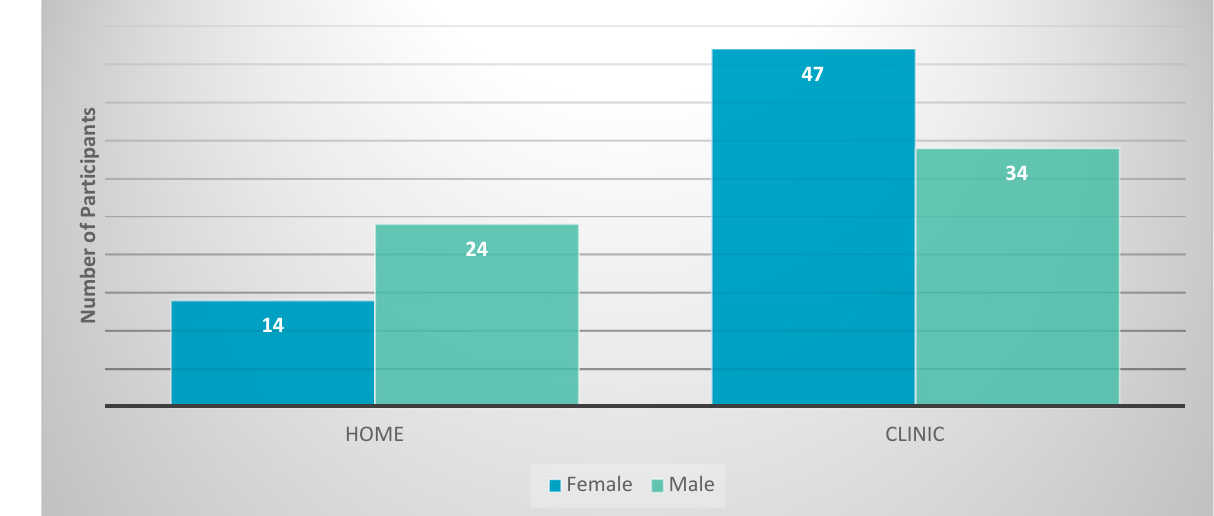
Figure 1. Testing location preference by gender. Table 2. Demographics and Preference for Testing